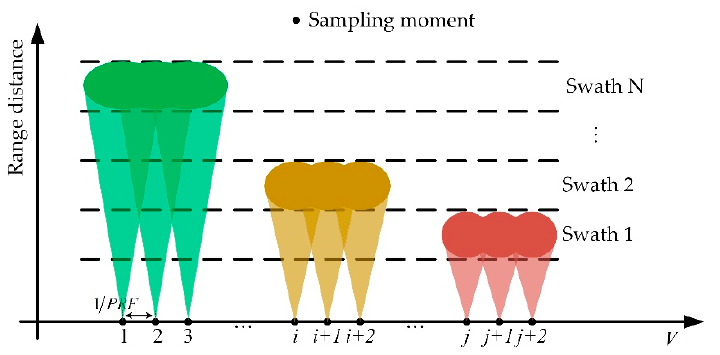
Figure 1. Pulse assignment diagram of the traditional scanning method, where the antenna beam jumps periodically among different subswaths. N indicates the number of subswaths.